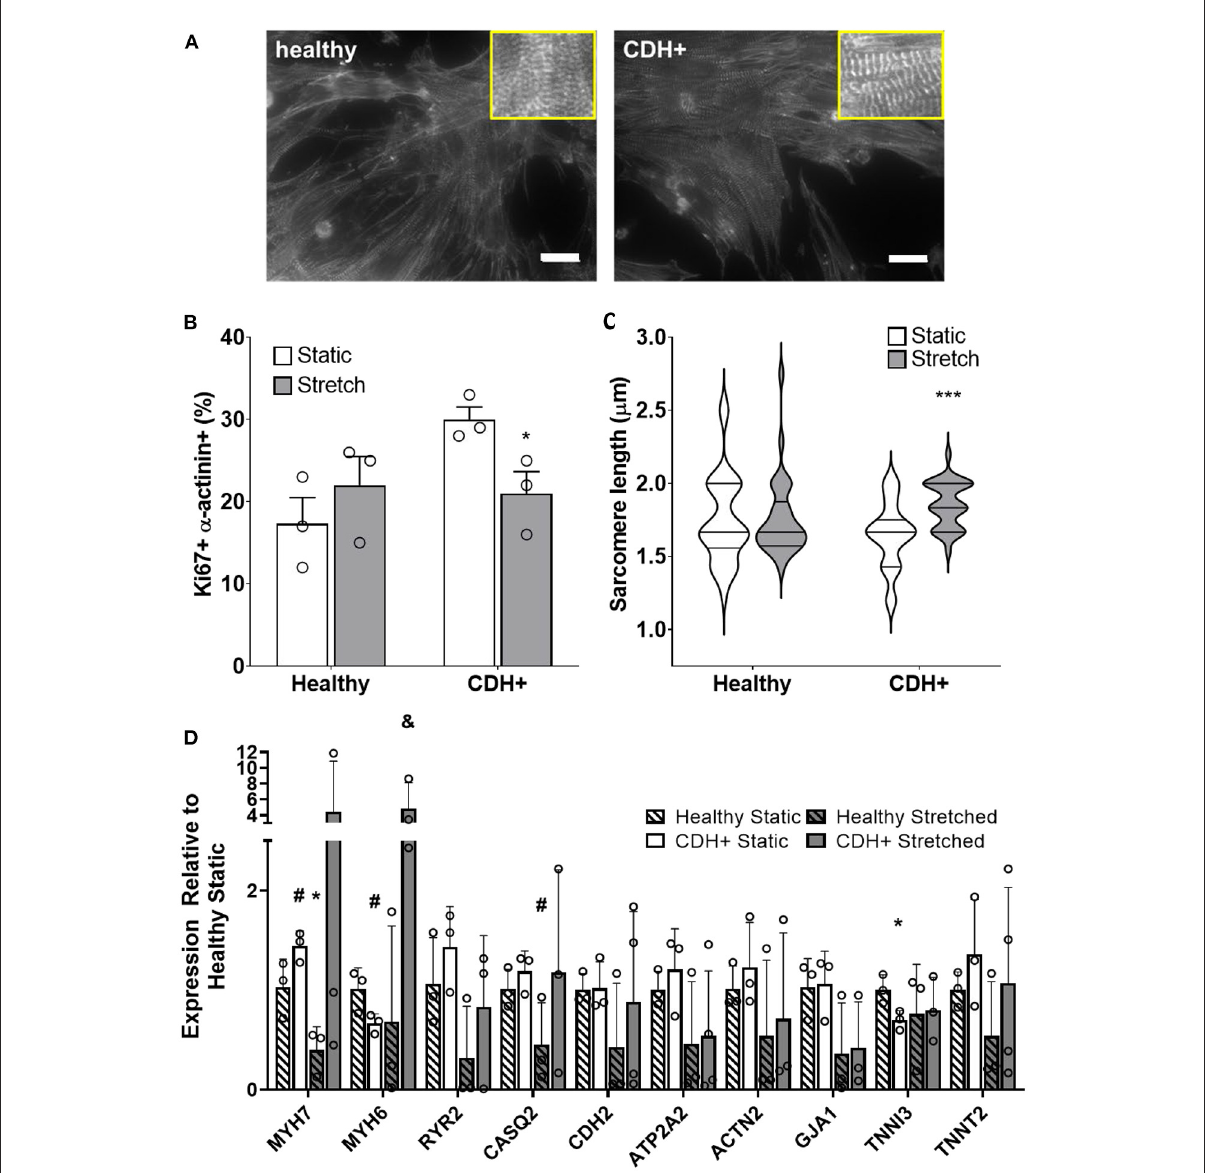
FIGURE6 Cardiomyocyte responses to stretch. (A) Representative images of stretched cardiomyocytes ( α -actinin stain). Insets show sarcomeres. Scale bars = 25 µ m. (B) Cardiomyocyte proliferation was not significantly affected by stretch in healthy cells but was significantly decreased in CDH + cells with stretch. Graph shows mean ± SD ( n = 3). * Denotes p < 0.05. (C) CDH + cardiomyocytes underwent lengthening of sarcomeres in response to stretch. Graph shows mean ± SEM ( n ≥ 23). *** Denotes p < 0.001. (D) Panel of genes measured in healthy and CDH + cells during both static conditions and following stretch. * Denotes p < 0.05w.r.t Healthy Static, # denotes p < 0.1w.r.t Healthy Static, and & denotes p < 0.1w.r.t CDH +